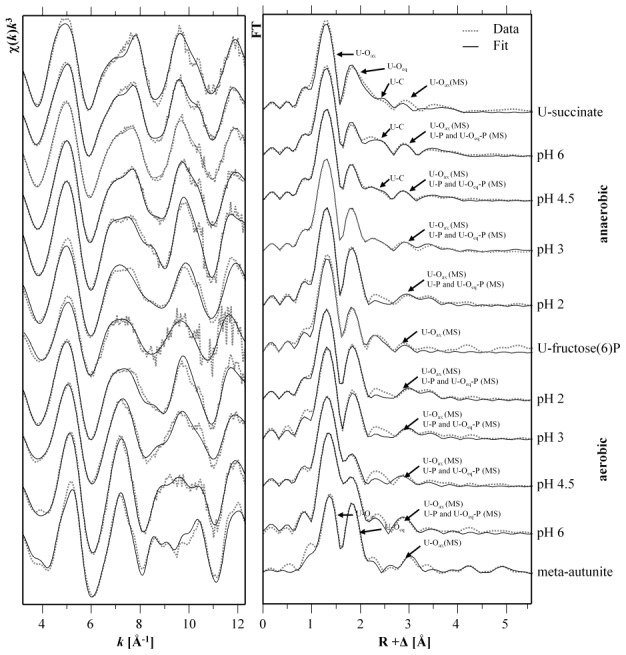
U L
III-edge k
3-weighted EXAFS spectra (left) and the corresponding Fourier Transforms (right) (3.1 Å−1<k<12.4 Å−1) of the uranium complexes formed by Paenibacillus sp. JG-TB8 at pH 2, pH 3, pH 4.5, and pH 6 at different pH and aeration conditions within 48 hours.For comparison, the spectra of three model compounds, namely uranyl succinate, uranyl-fructose(6)phosphate, meta-autunite are illustrated as well.